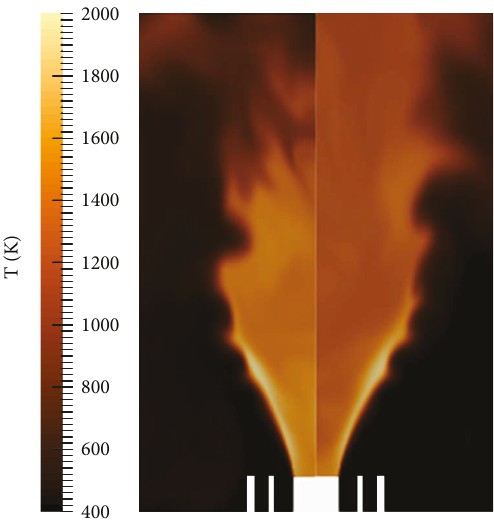
Figure 16: Comparison of instantaneous temperature simulated using di ff erent mechanisms.